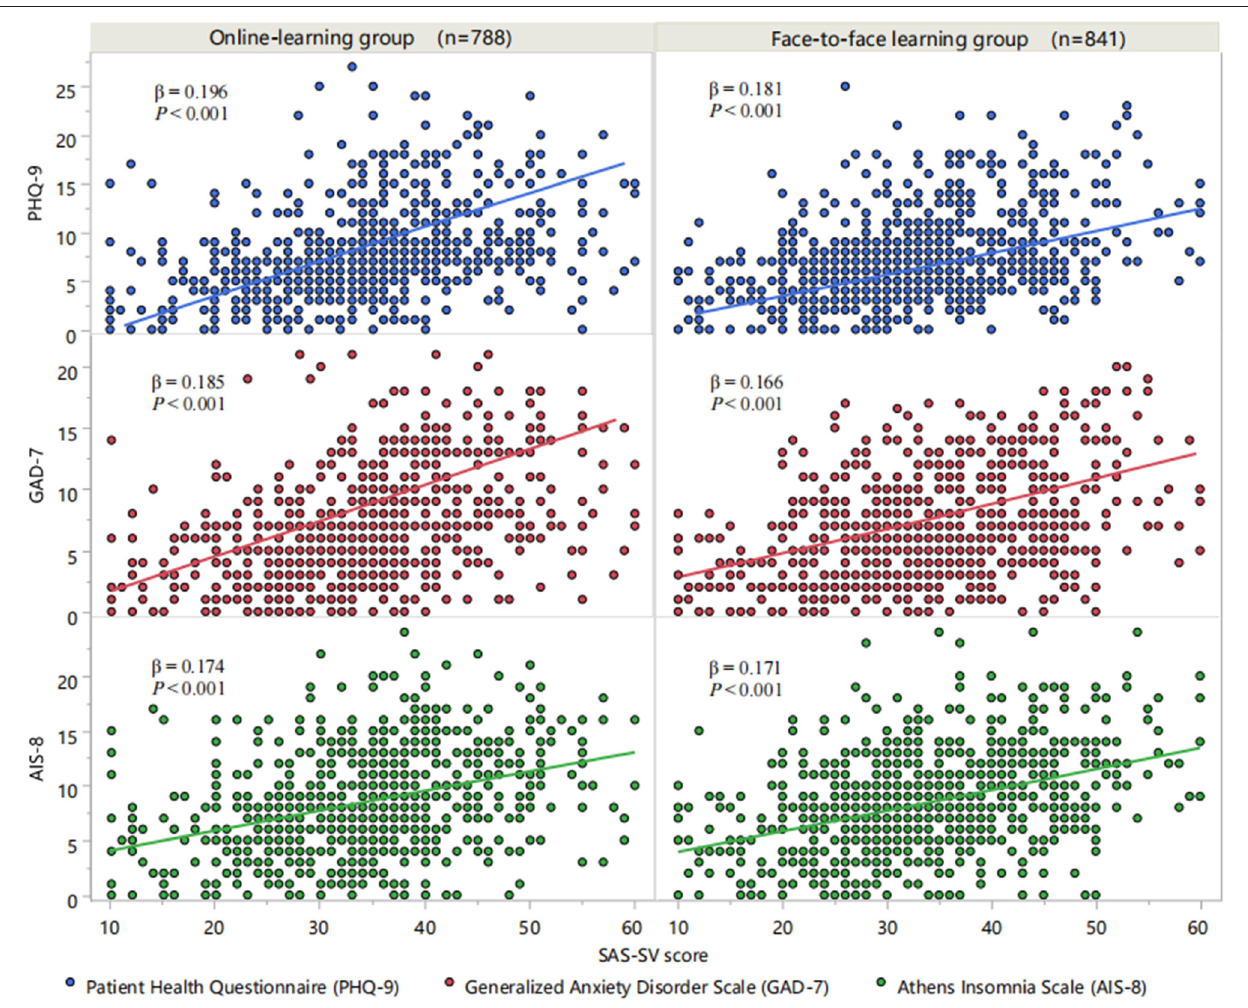
Frontiers in Public Health |